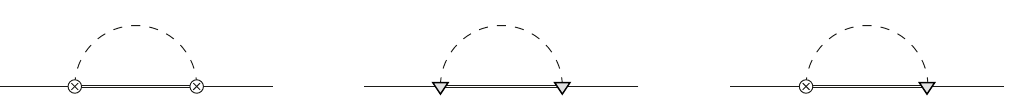
Figure 7 . Self-energy of a heavy pair in a bound state (solid line) induced by the quadrupole (crossed vertex) interaction, derivative interaction (triangle vertex) and their mixing. The internal single line stands for a heavy pair in a scattering